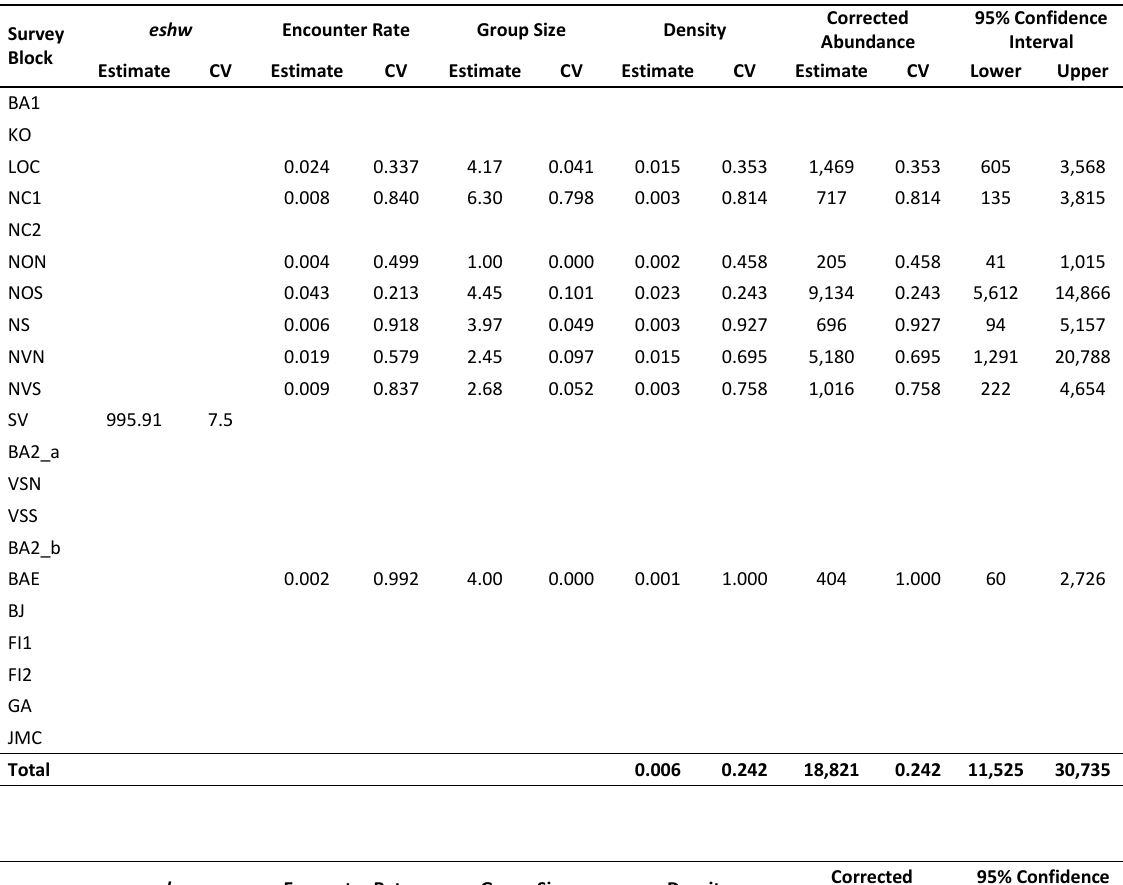
Table 9. Estimated density and abundance of killer whales from the 2002 – 2007 survey (a) and the 2008 – 2013 survey (b). The eshw (effective search half width (m)) was estimated for the entire study region. Encounter rate, group size, density, abundance, and upper and lower confidence limits were estimated by block and corrected for perception bias, with the estimated p